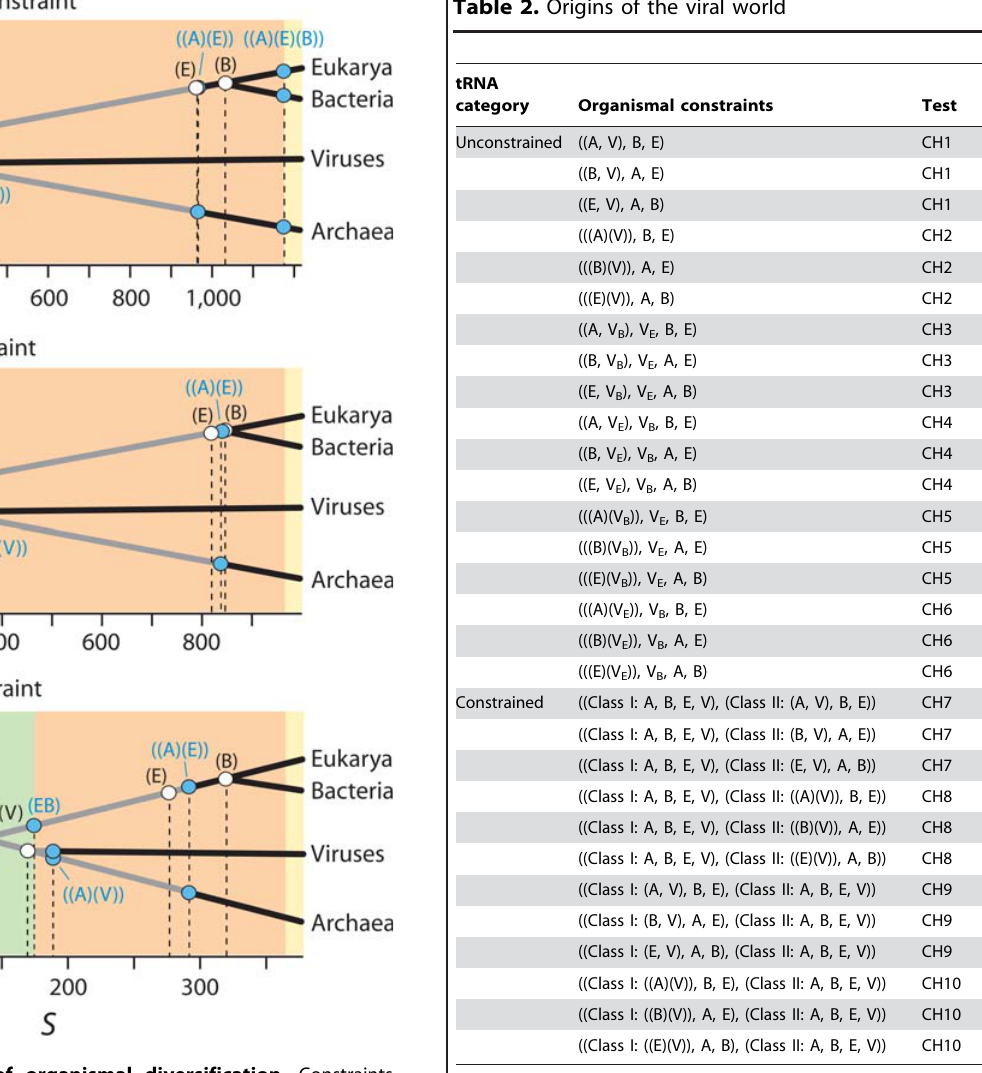
Figure 2. Timeline of organismal diversification. Constraints representing non-competing hypotheses of organismal relationship (white circles) are used to define a timeline for the appearance of lineages in a universal tree derived from the sequence and structure of tRNA. Blue circles represent constraints representing competing hypotheses. They illustrate both the most parsimonious lineage relationship and their coalescence. Areas colored in light green, salmon, and light yellow are delimited by lineage coalescence and describe three evolutionary epochs. The timeline is given in a scale of additional steps ( S ) needed to fulfill constraints. S values were not normalized.